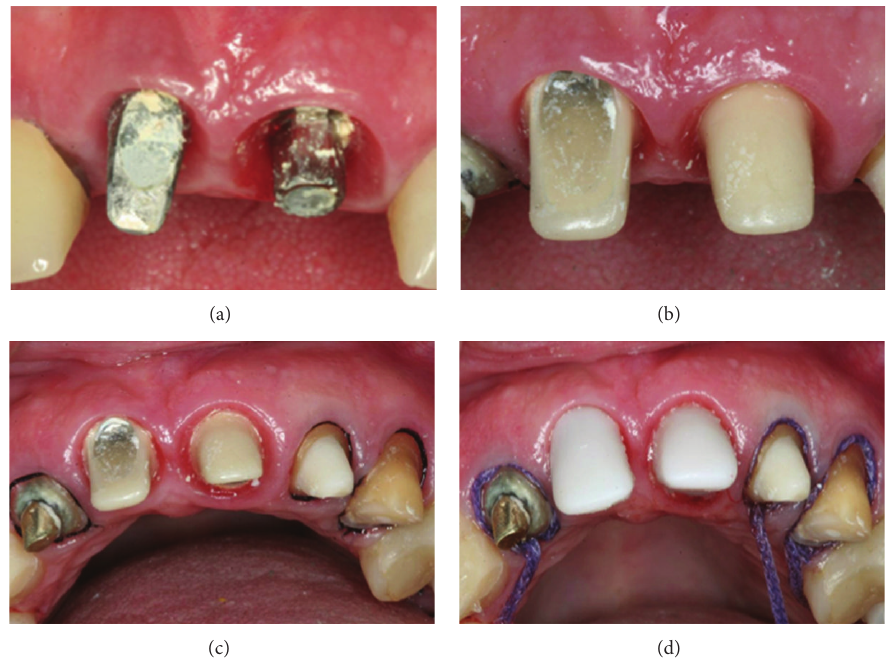
Figure 9: IPS and max press copings used to restore the maxillary central and left incisors and left canine.